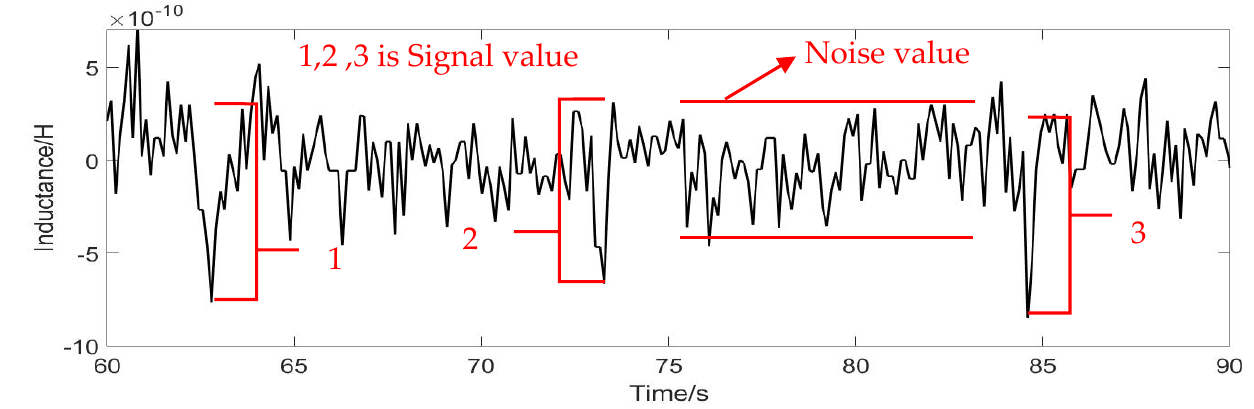
Figure 14. Signal of 80 µ m copper particles.